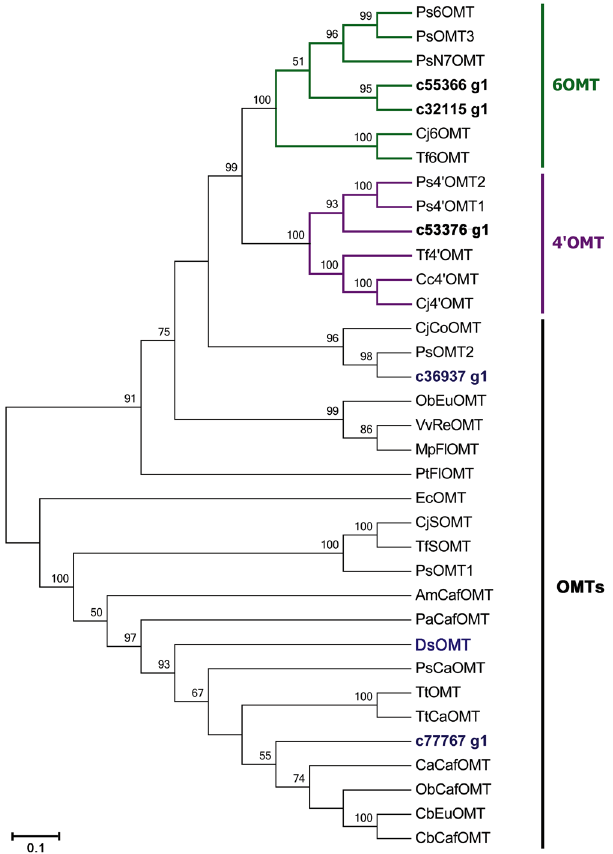
Figure 5. Phylogenetic tree of OMTs. Phylogenetic tree was constructed based on the deduced amino acid sequences for the D . scandens OMTs (bold letters) and other plant OMTs. Abbreviations and GenBank accession numbers for the sequences used are as follows: EcOMT, putative Eschscholzia californica OMT (ACO90220.1); CjCoOMT, Coptis japonica columbamine OMT (Q8H9A8.1); TtOMT, Thalictrum tuberosum catechol OMT (AAD29845.1); TtCaOMT, T . tuberosum catechol OMT (AAD29843.1); PsCaOMT, P . somniferum catechol OMT (AAQ01670.1); PsN7OMT, P . somniferum norreticuline 7OMT (ACN88562.1); Ps6OMT, P . somniferum norcoclaurine 6OMT (AAP45315.1); Ps4 ′ OMT2, P . somniferum 3 ′ -hydroxy-N-methylcoclaurine 4 ′ OMT2 (AAP45314.1); Ps4 ′ OMT1, P . somniferum 3 ′ -hydroxy-N-methylcoclaurine 4 ′ OMT1 (AAP45314.1); Cc4 ′ OMT, Coptis chinensis 3 ′ -hydroxy-N-methylcoclaurine 4 ′ OMT (ABY75613.1); Cj4 ′ OMT, C . japonica 3 ′ -hydroxy-N-methylcoclaurine 4 ′ OMT (Q9LEL5.1); Tf4 ′ OMT, T . flavum 3 ′ -hydroxy-N-methylcoclaurine 4 ′ OMT (AAU20768.1); Cj6OMT, C . japonica norcoclaurine 6OMT (Q9LEL6.1); Tf6OMT, T . flavum norcoclaurine 6OMT (AAU20765.1); VvReOMT, Vitis vinifera resveratrol OMT (CAQ76879.1); PtFlOMT, Populus trichocarpa flavonoid OMT predicted protein (XP_002312933.1); CjSOMT, C . japonica scoulerine 9OMT (Q39522.1); TfSOMT, T . flavum scoulerine 9OMT(AAU20770.1); PaCafOMT, Picea abies caffeate OMT (CAI30878.1); CaCafOMT, Capsicum annuum caffeate OMT (AAG43822.1); PsOMT1, P . somniferum SOMT1 (JN185323); PsOMT2, P . somniferum SOMT2 (JN185324); PsOMT3, P . somniferum SOMT3 (JN185325); ObEuOMT, Ocimum basilicum eugenol OMT (AAL30424.1); MpFlOMT, Mentha X piperita flavonoid 8OMT (AAR09600.1); ObCafOMT, O . basilicum caffeate OMT (AAD38189.1); CbEuOMT, Clarkia breweri (iso) eugenol OMT (AAC01533.1); CbCafOMT, C . breweri caffeate OMT (O23760.1); and AmCafOMT, Ammi majus caffeate OMT